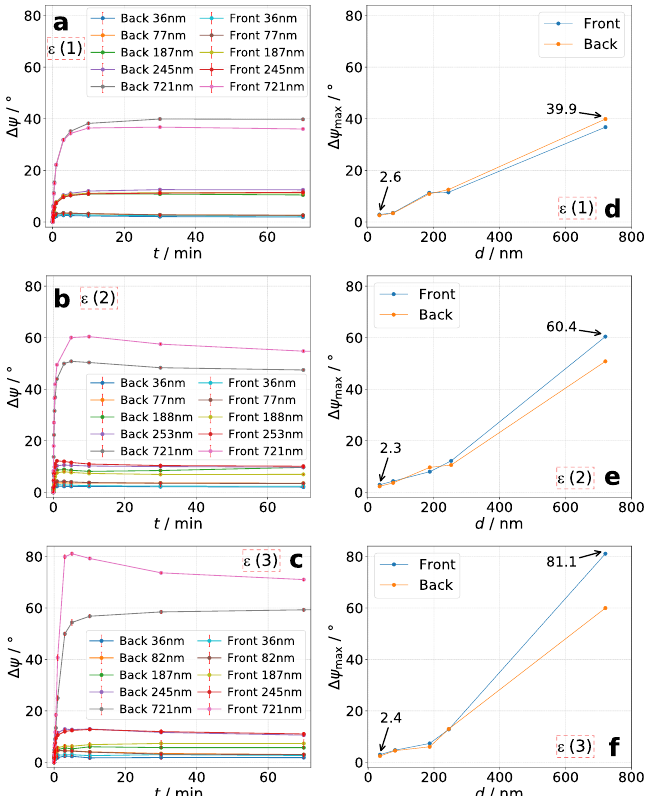
Figure 5. Polymer P2 : Time-resolved azimuthal rotation ∆ ψ for various d ( a – c ) and its corresponding maximum azimuthal rotation ∆ ψ max ( d – f ) for each sample. Ellipticity combination of excitation and analysis laser are: ( a , d ): (cid:101) ( 1 ) , ( b , e ): (cid:101) ( 2 ) , and ( c , f ): (cid:101) ( 3 ) (see Table